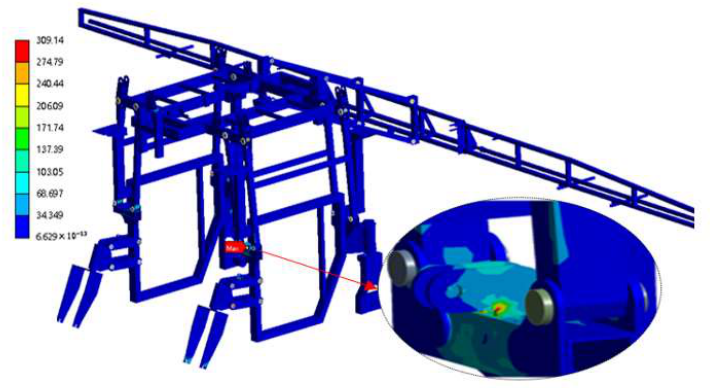
Table 4. First 12 orders of inherent frequency.